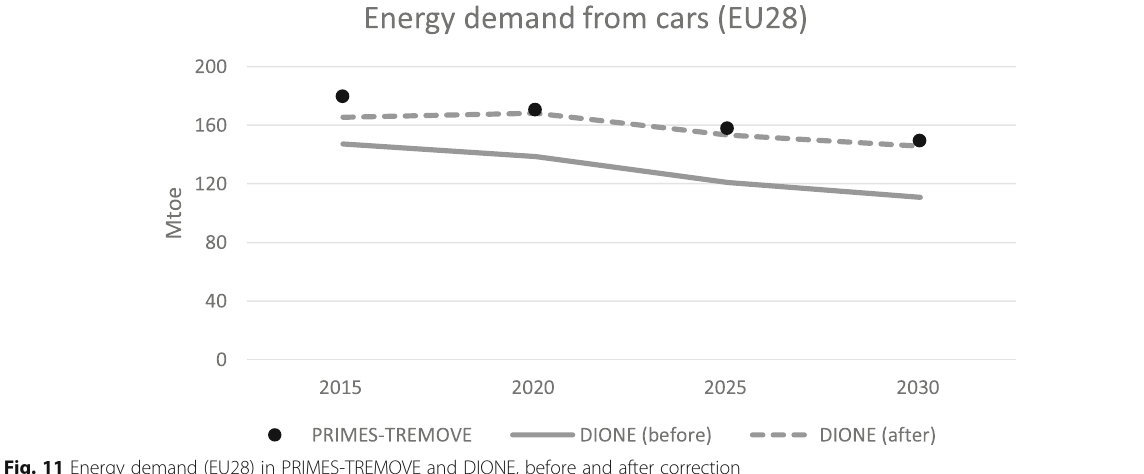
Fig. 11 Energy demand (EU28) in PRIMES-TREMOVE and DIONE, before and after correction